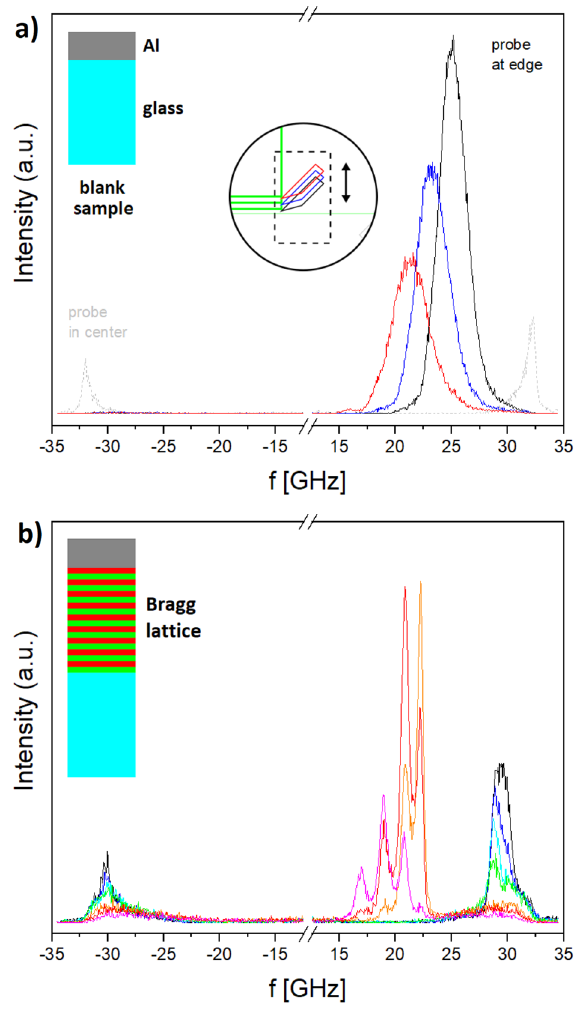
Figure 3. Hybrid pump-probe spectra, with inset in the upper left corner illustrating sample structure ( a ) blank sample (glass with > 200 nm Al-film), showing the effect of knife-edge mirror translation (circular inset) on frequency and intensity of the scattered light, with higher frequencies corresponding to positions closer to the entrance pupil center (dashed grey spectrum shows pump-enhanced backscattering i.e. thin green beam path in Fig. 1); differential screw interval 0.25 mm and acquisition time 30 s for spectra from the edge-injected beam (backscattering spectrum not to scale) ( b ) transmission function of Bragg mirror (as in Fig. 2) for various knife-edge mirror positions; differential screw interval 0.25 mm for spectra showing transmission below the bandgap, and 0.125 mm for spectra showing transmission above the bandgap; acquisition time 5 min for all spectra (colors arranged similarly to the top plot, with black for the mirror closest to the center, and the order of all other positions indicated by a rainbow